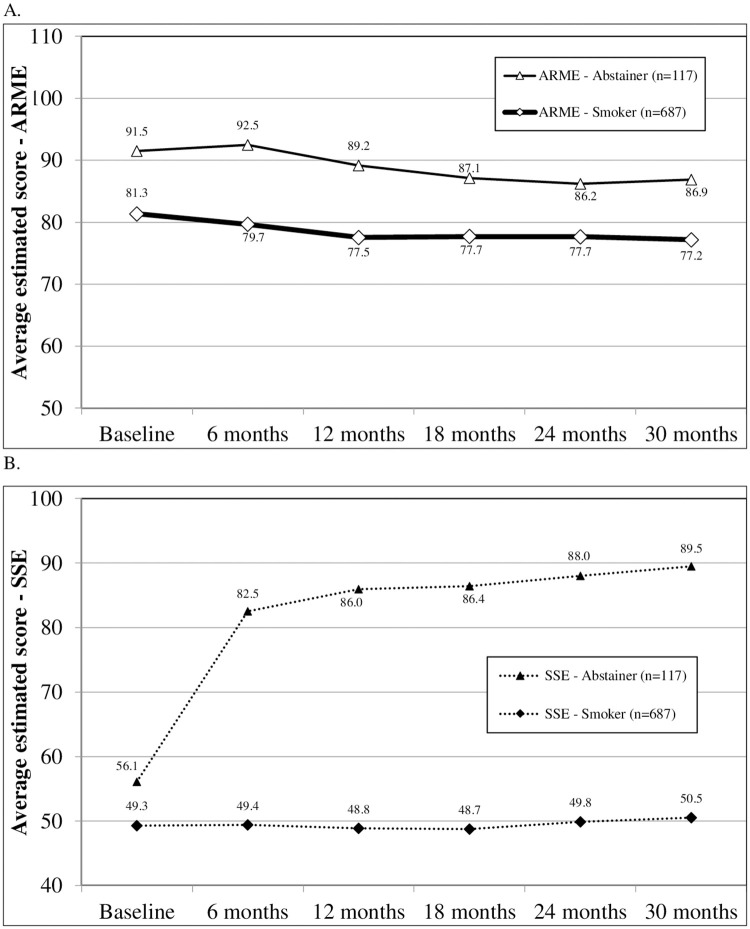
Trajectories for ARME (A) and SSE (B) for those continuously abstinent or continuously smoking during follow up.The ARME scale ranges from 16 to 112. The SSE scale ranges from 20 to 100.